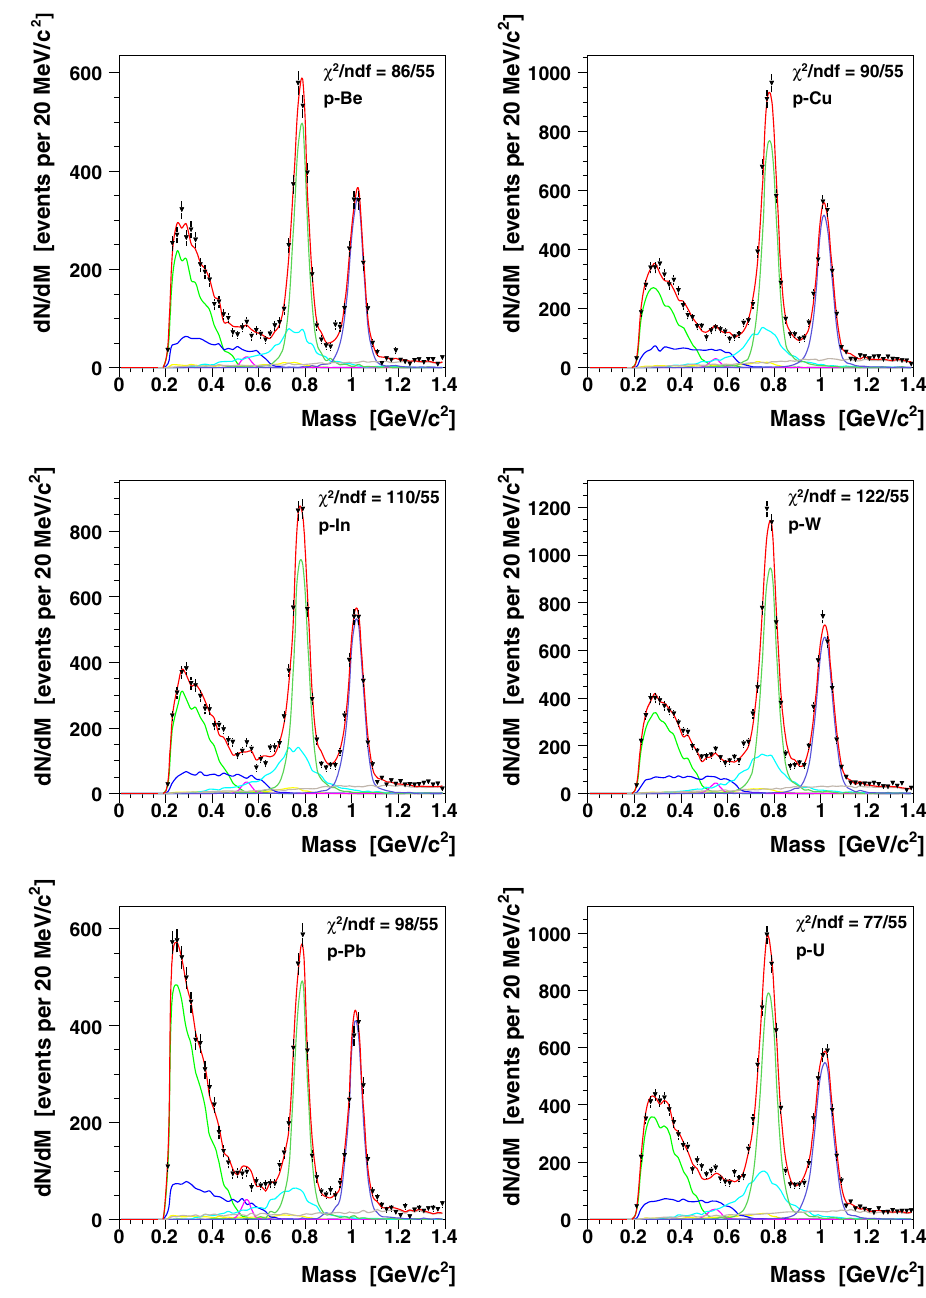
T -integrated dimuon mass spectra for the different production targets, with the superposition of the expected sources: η → μ + μ − γ (light green, dominating for masses below 0 . 5GeV/c 2 ), η → μ + μ −